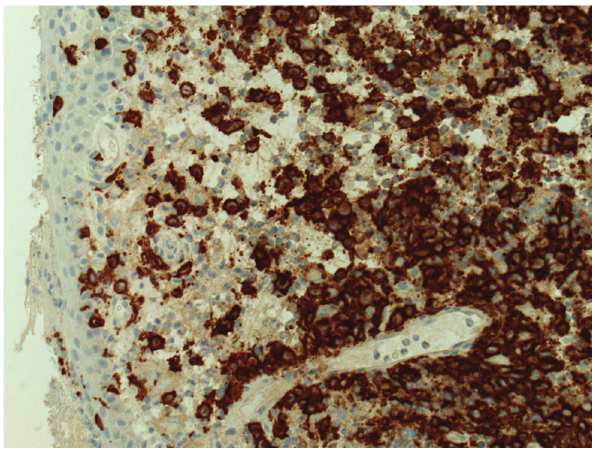
Figure 2: CD1a immunohistochemical stain highlighting the Langerhans cells (×20)